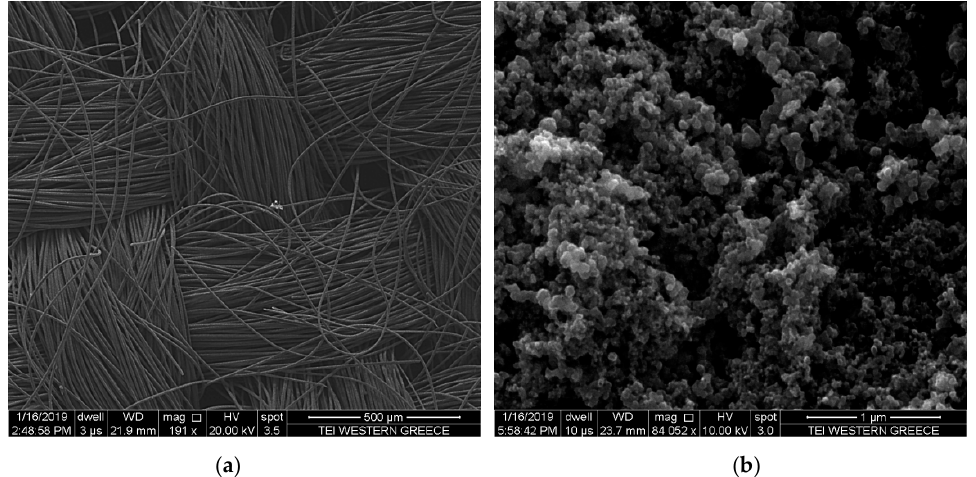
Figure 5. SEM images of the structure of the carbon cloth electrode ( a ) and the mesoporous carbon film ( b ).